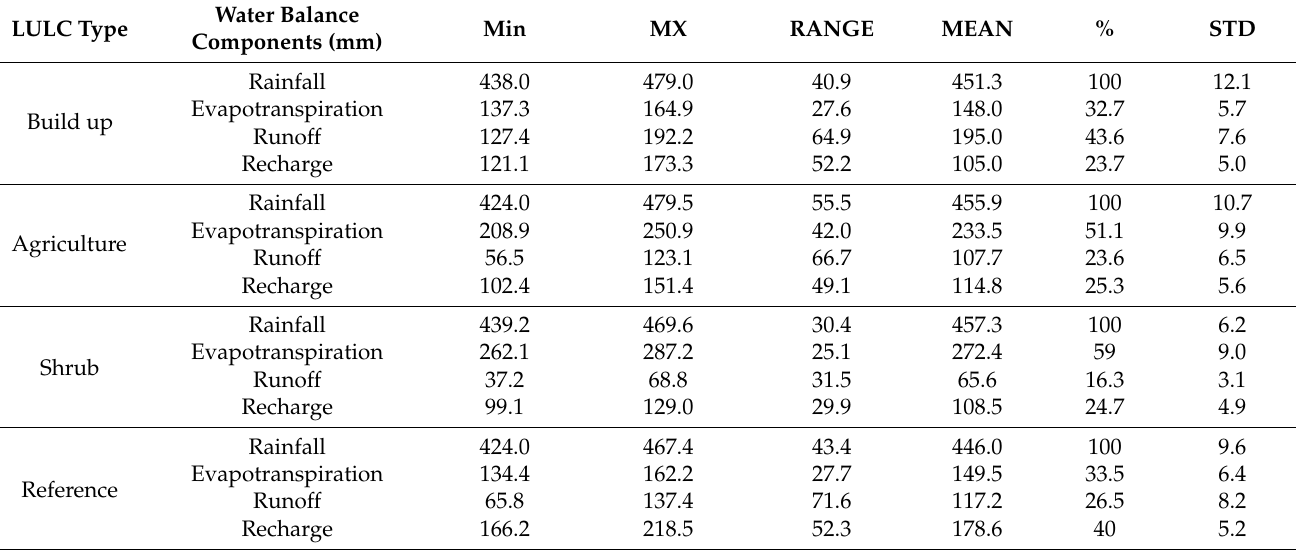
Table A1. Average annual water balance components as a function of land-use types.